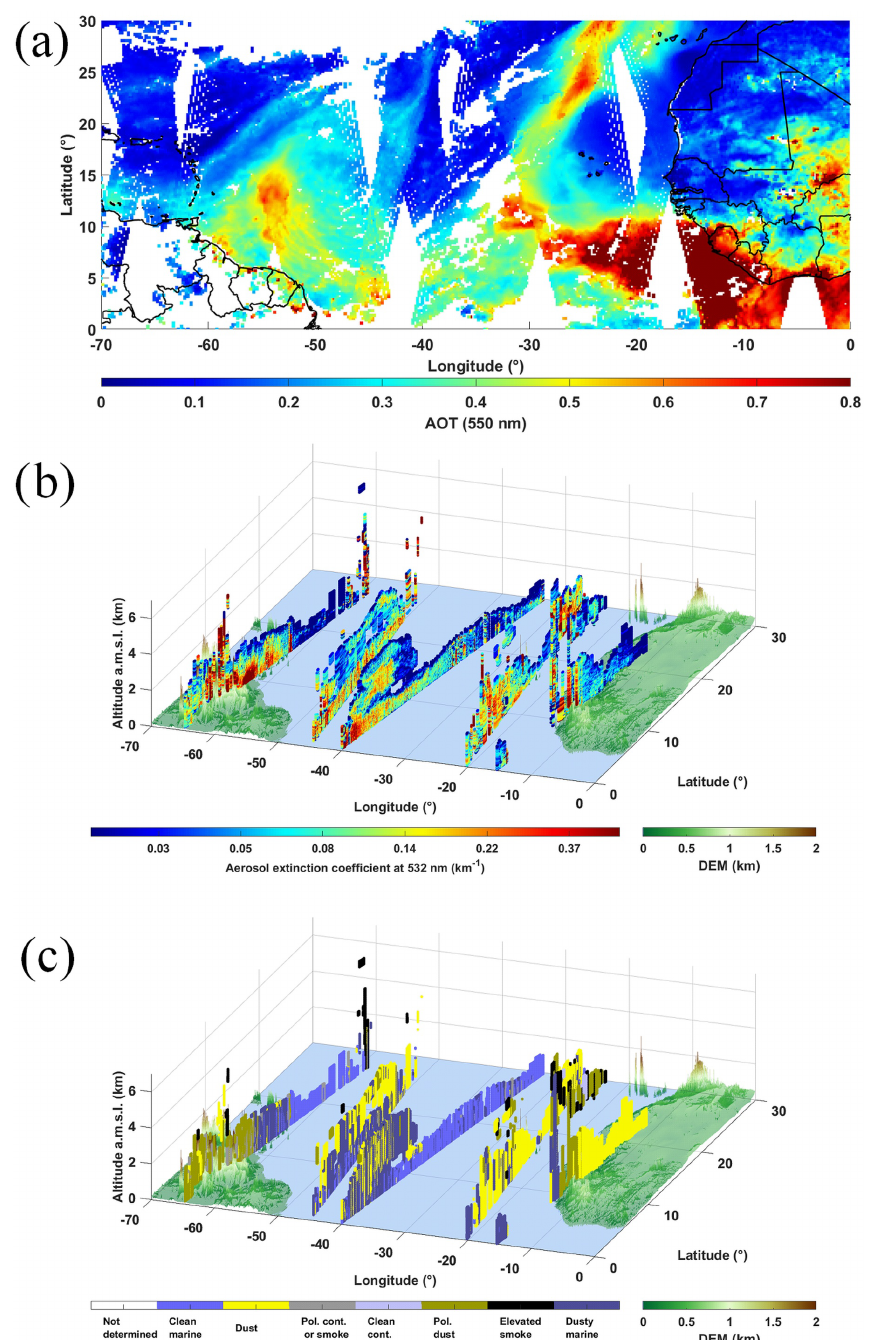
Figure 7. (a) MODIS-derived AOT at 550nm, (b) CALIOP aerosol extinction coefficient at 532nm for all orbits, and (c) CALIOP aerosol classification for all orbits on 31 January 2020, in V4.1 version of the operational